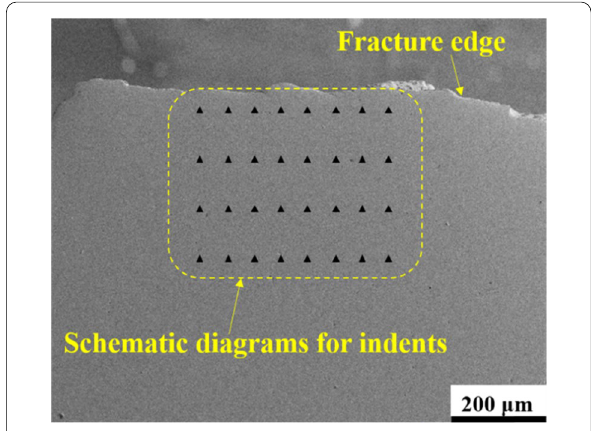
Figure 4 Schematic diagrams of nanoindentation position for CF-tested specimens